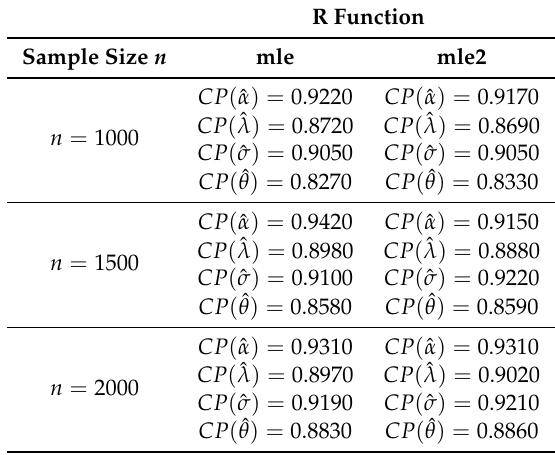
Table 4. Average coverage probability (CP) at the 95% confidence level for the composite Weibull–Pareto (CWL) model involving 1000 simulations of samples of size n for the mle (second column) and mle2 (third column)